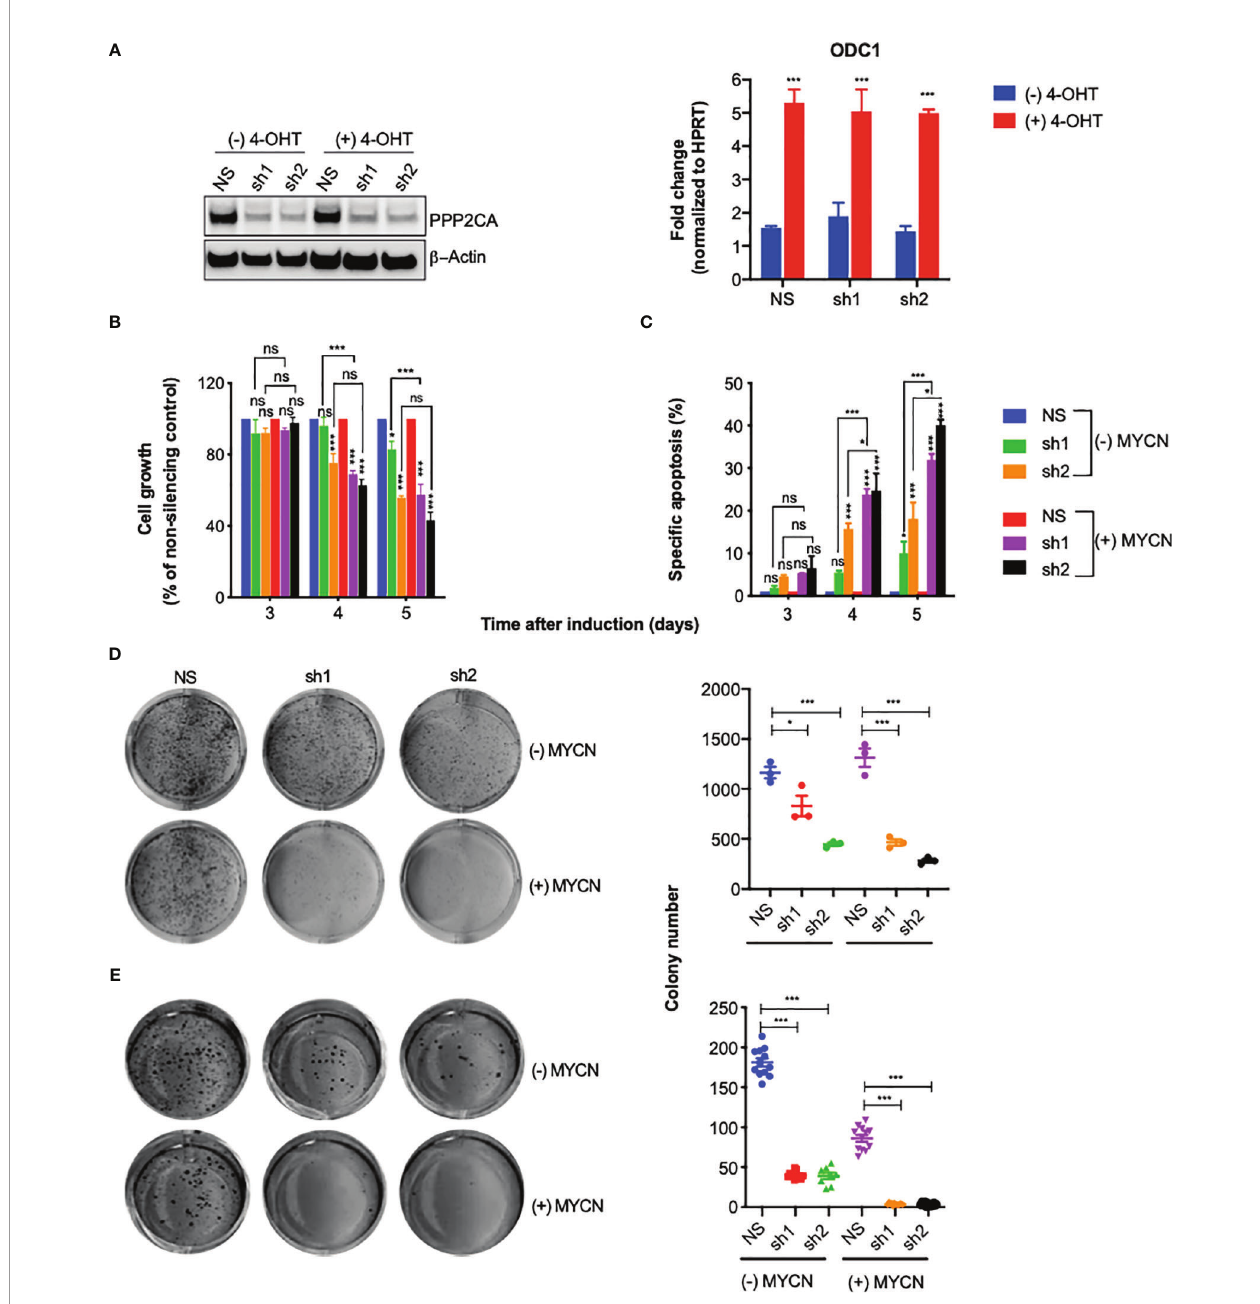
FIGURE 2 | Knock-down of PPP2CA inhibits aggressiveness of SH-EP-MYCN-ER neuroblastoma (NB) cells, enhanced by MYCN activation. SH-EP-MYCN-ER cells with (+) or without ( − ) activation of MYCN by 4-hydroxytamoxifen (4-OHT) were treated with doxycycline to induce expression of lentivirally transduced shRNAs. NS, non-silencing control; sh1, PPP2CA-silencing shRNA1; sh2, PPP2CA-silencing shRNA2. (A) Knock-down of PPP2CA and activation of MYCN. Western blotting of PPP2CA and b -actin (left panel). Full-length Western blotting is shown in Supplementary Figure 2A . qRT-PCR of ODC1 normalized to HPRT (right panel). (B) Inhibition of cell growth. Viable, i.e., Hoechst stain-negative, cells were enumerated by fl ow cytometry. Cell growth as percentage of cells compared to non-silencing control is shown for different time points after induction by doxycycline. (C) Induction of apoptosis. Apoptosis was determined by enumerating hypodiploid propidium iodide-stained nuclei using fl ow cytometry. Shown is the speci fi c percentage of apoptotic nuclei. (D) Inhibition of clonogenicity. Cells were grown in plastic dishes for 1 week and stained with crystal violet, and colonies were counted. (E) Inhibition of anchorage-independent growth. Cells were grown in soft agar for 1 week and stained with MTT, and colonies were counted. Experiments were repeated three times. Data are expressed as means ± SEM of triplicates and analyzed by two-way ANOVA test. *p < 0.05, ***p < 0.001; ns, not signi fi